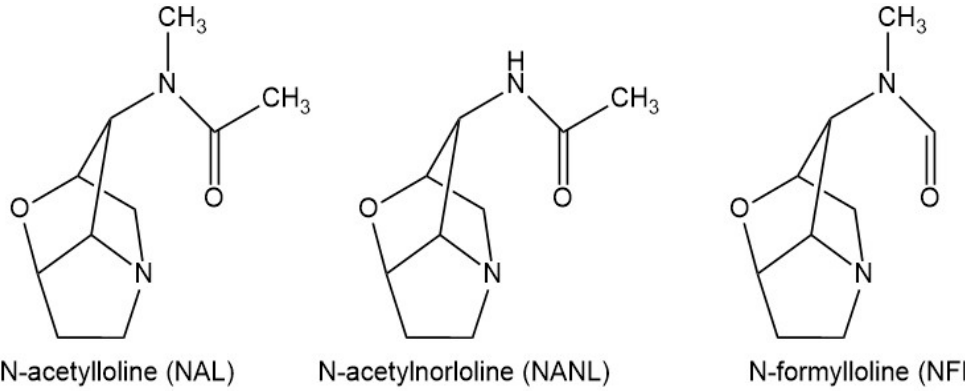
Figure 1. Chemical structures of N -acetylloline (NAL), N -acetylnorloline (NANL), N -formylloline (NFL).